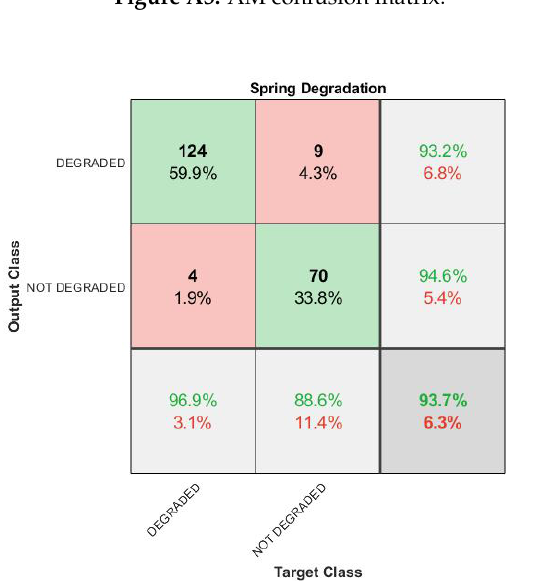
Figure A6. Degradation